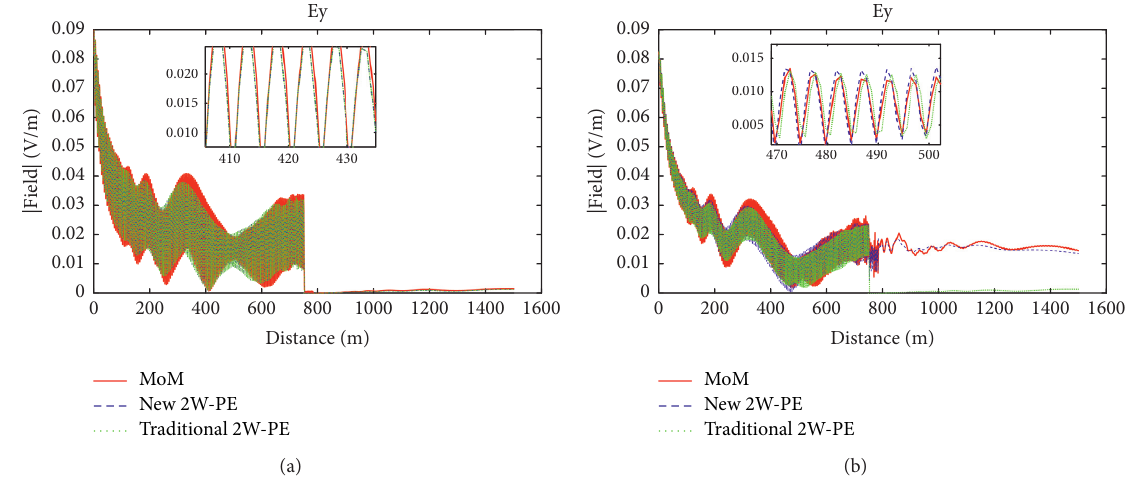
Figure 7: Comparison of total field values in the case of single rectangular medium obstacle of H Pol. (a) σ � 10 − 5 (S/m). (b) σ obstacle